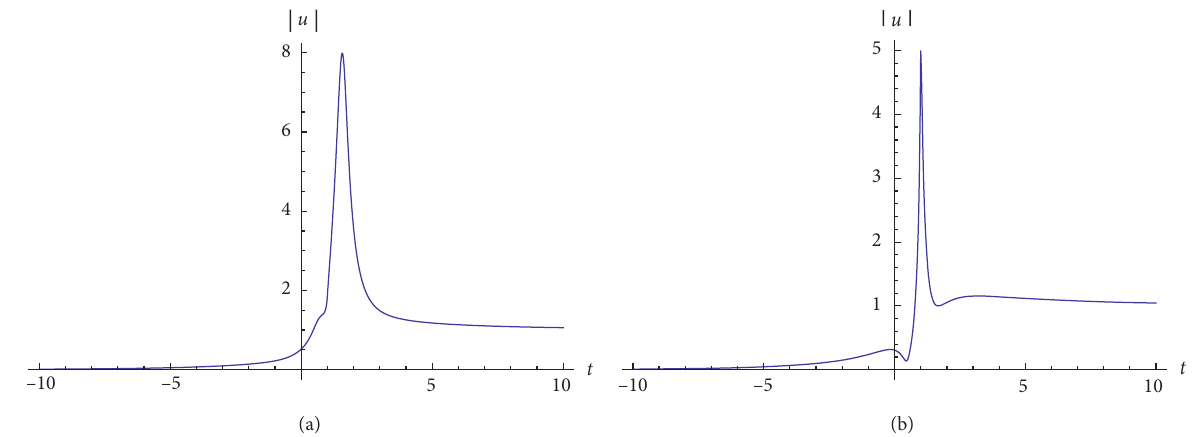
Figure 18: Dynamic evolution of the asymmetric second-order fractional rogue wave with α � 5/6 and a � 1 modified from solution (39). (a) x � 0. (b) x �